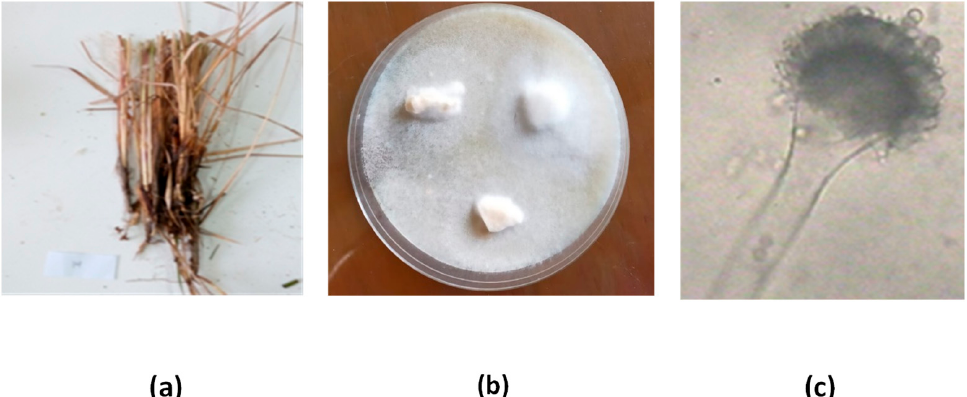
Figure 1. Isolation profile, ( a ) plant sample ( Juncus rigidus ), ( b ) isolation of fungi from Juncus rigidus , ( c ) Microscopic photo for morphological shape of Aspergillus .